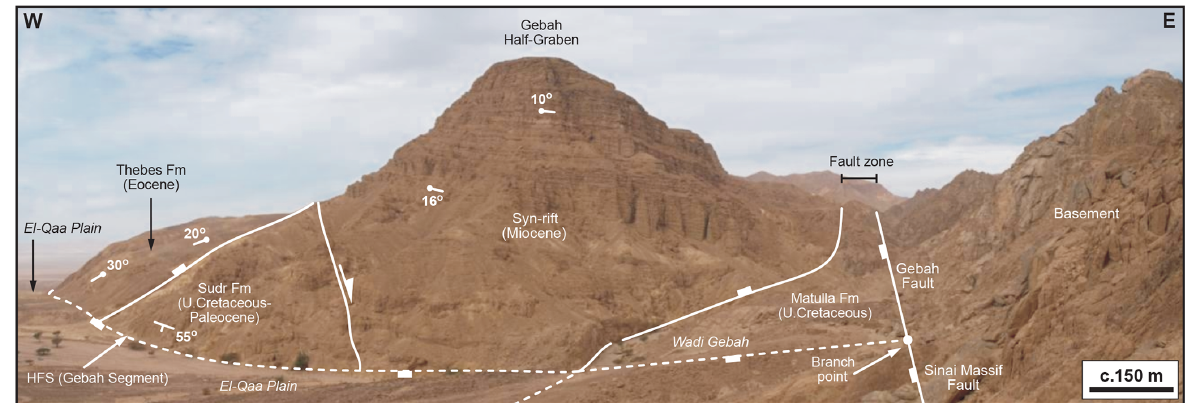
Figure 7. Photograph looking northwards along the Sinai Massif and Gebah faults, showing the branch point with the Gebah Segment of the Hadahid Fault System. The location of the photo is shown in Fig.